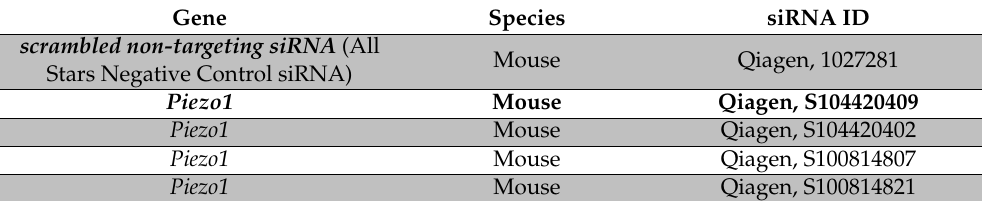
Table 1. List of siRNAs used. Gene Species siRNA ID scrambled non-targeting siRNA (All Mouse Qiagen, 1027281 Stars Negative Control siRNA) Piezo1 Mouse Qiagen, S104420409 Piezo1 Mouse Qiagen, S104420402 Piezo1 Mouse Qiagen, S100814807 Piezo1 Mouse Qiagen,